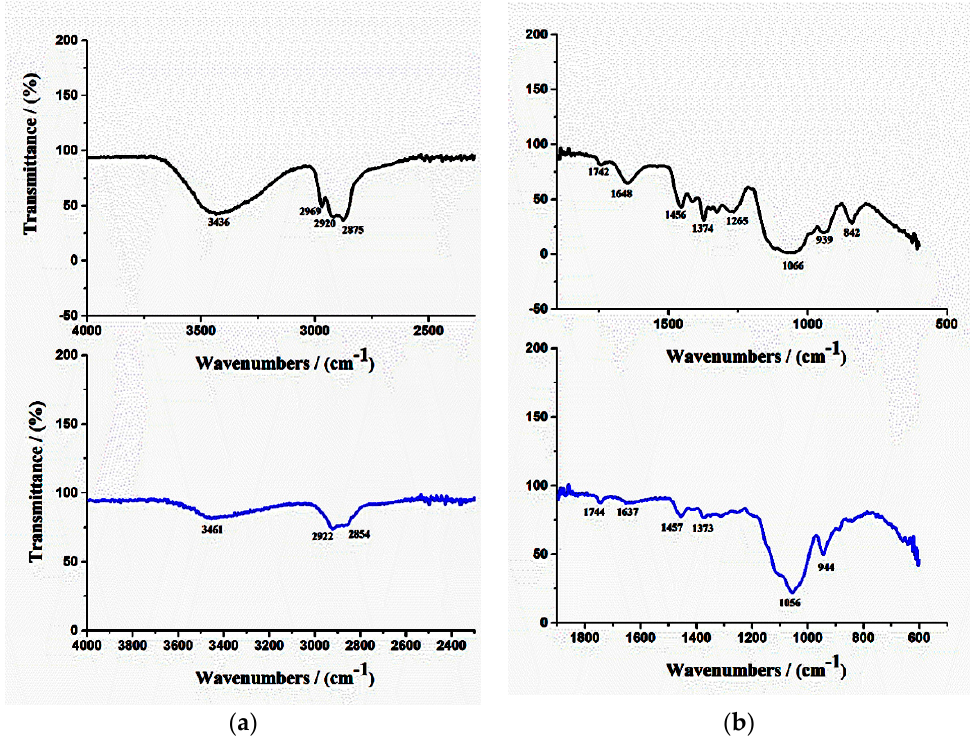
Figure 3. FTIR spectra of R (black line) and F-UBE-HPC (blue line), in the range of 4000–2000 cm − 1 ( a ) and 2000–400 cm − 1 ( b ). R—bioadhesive oral film without active lichen extract; F-UBE-HPC— bioadhesive oral film loaded with U. barbata dry ethanol extract.